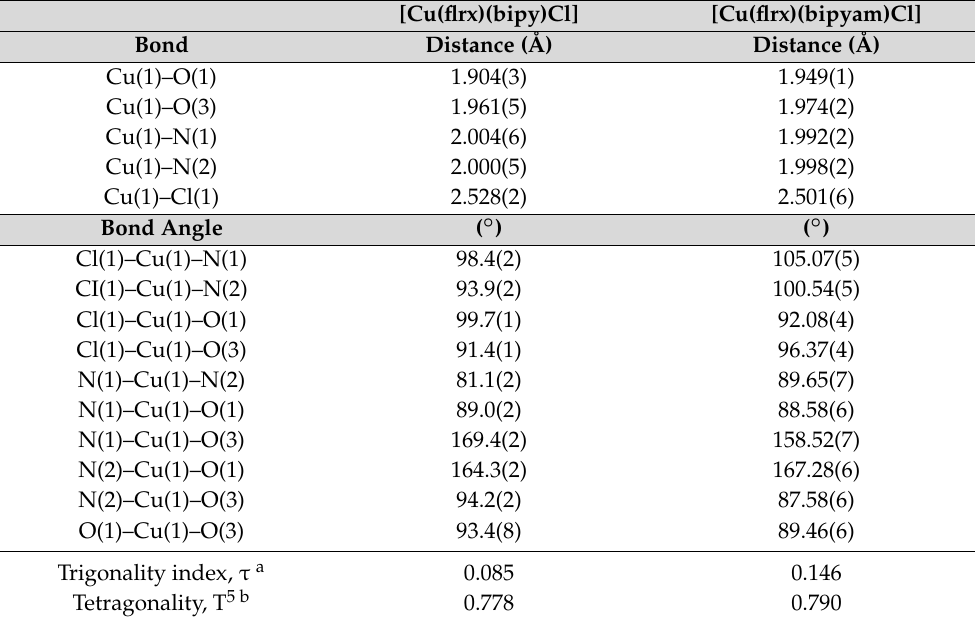
Table 2. Selected bond distances, bond angles and structural features for complexes 6 and 7